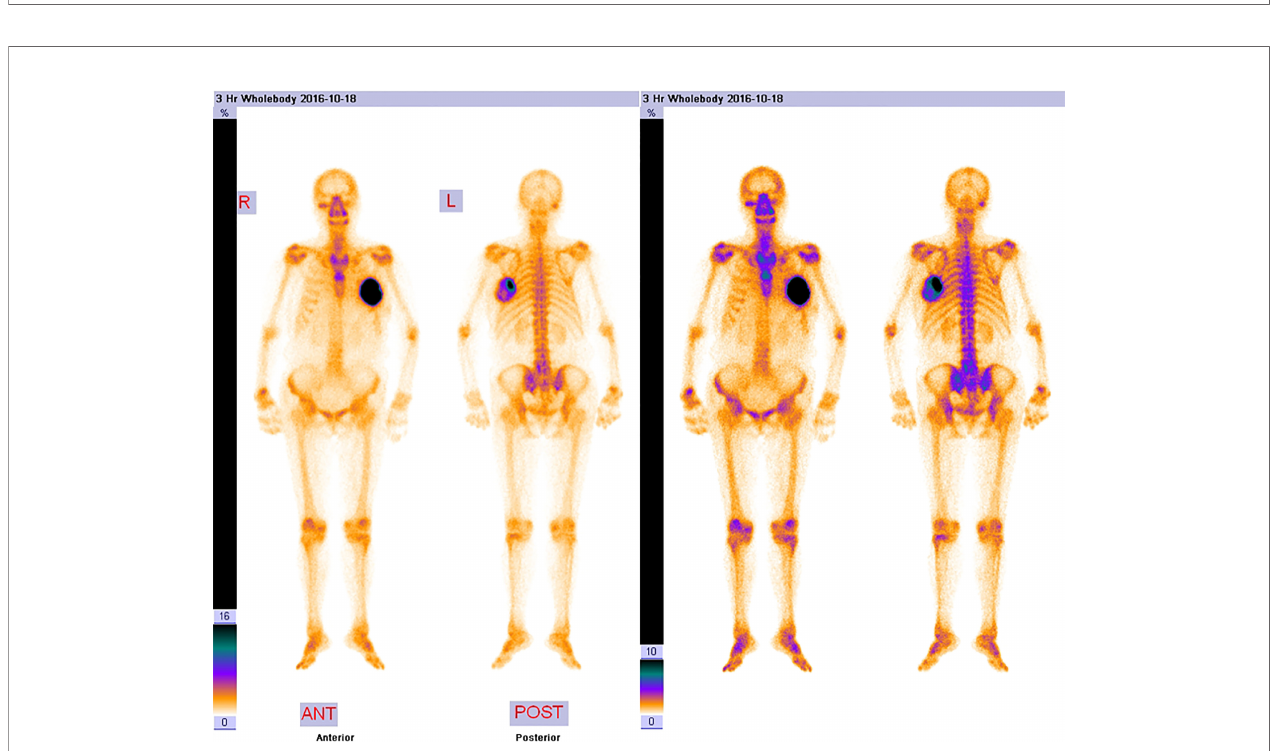
FIGURE 2 | The 99mTc-MDP whole-body bone imaging. It showed that there was a mass-like abnormal radioactive concentration of Tc-99m outside the bone of the left chest, without other abnormal concentrations.